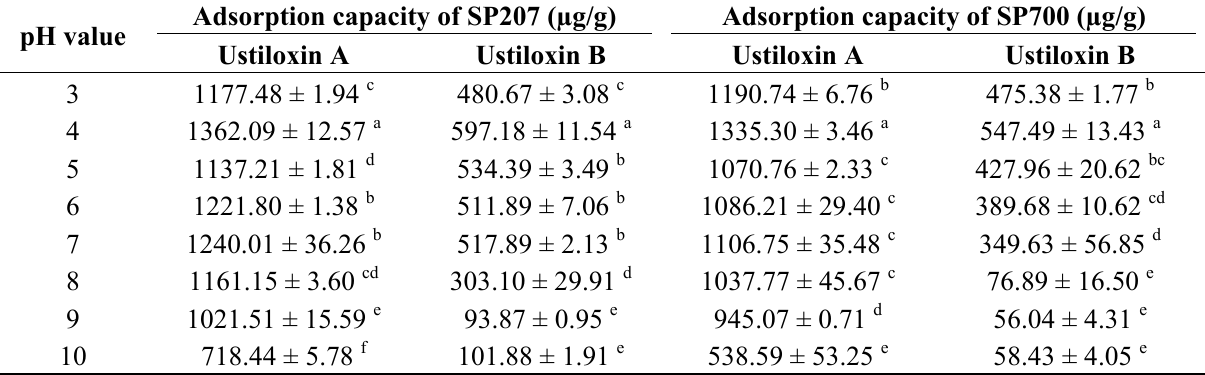
Table 3. Effects of pH values of sample solution on the adsorption capacities of resins SP207 and